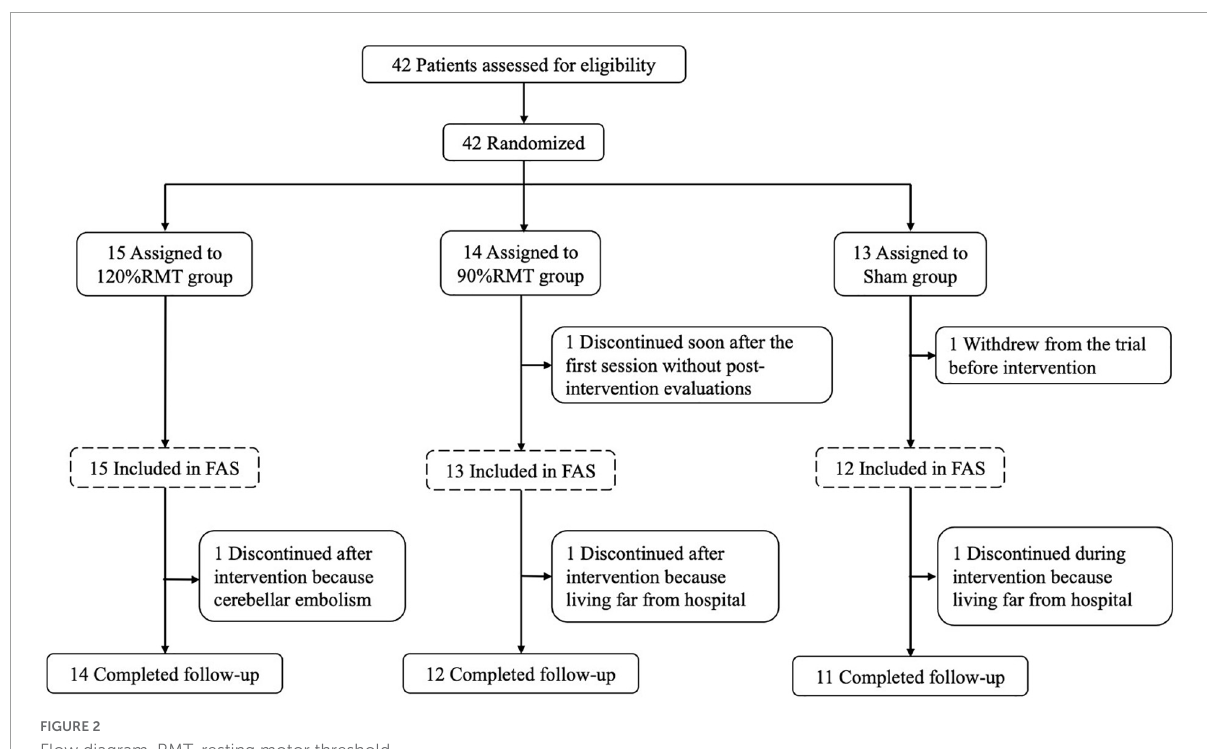
FIGURE2 Flow diagram. RMT, resting motor